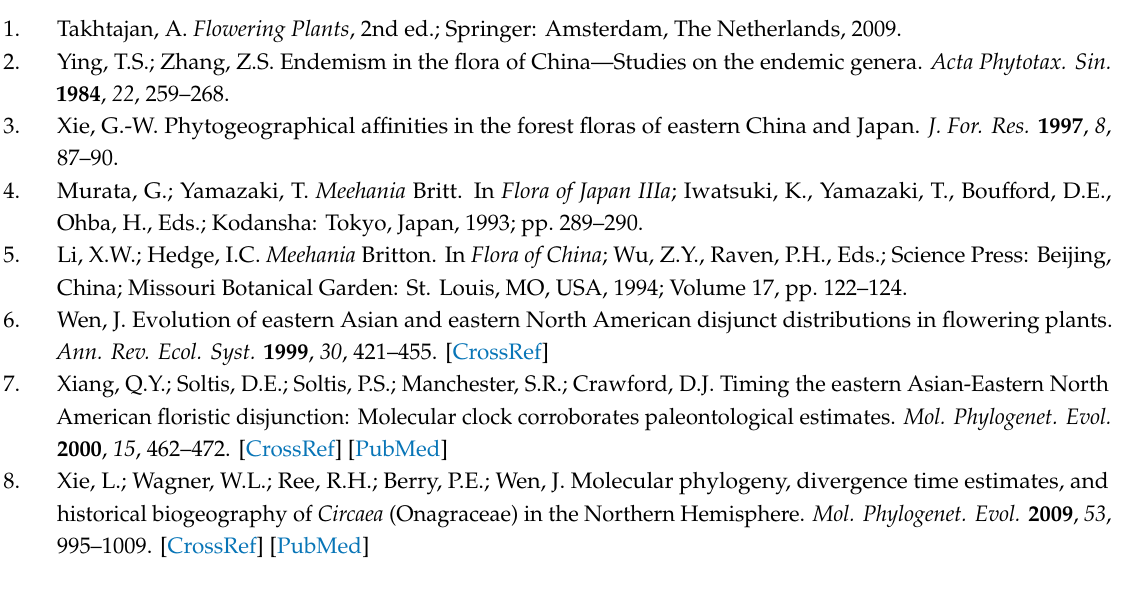
Table S1: Samples, vouchers, and accession number of ETS and ITS sequences used in this study. Accession number in bold letter indicates the sequences determined in this